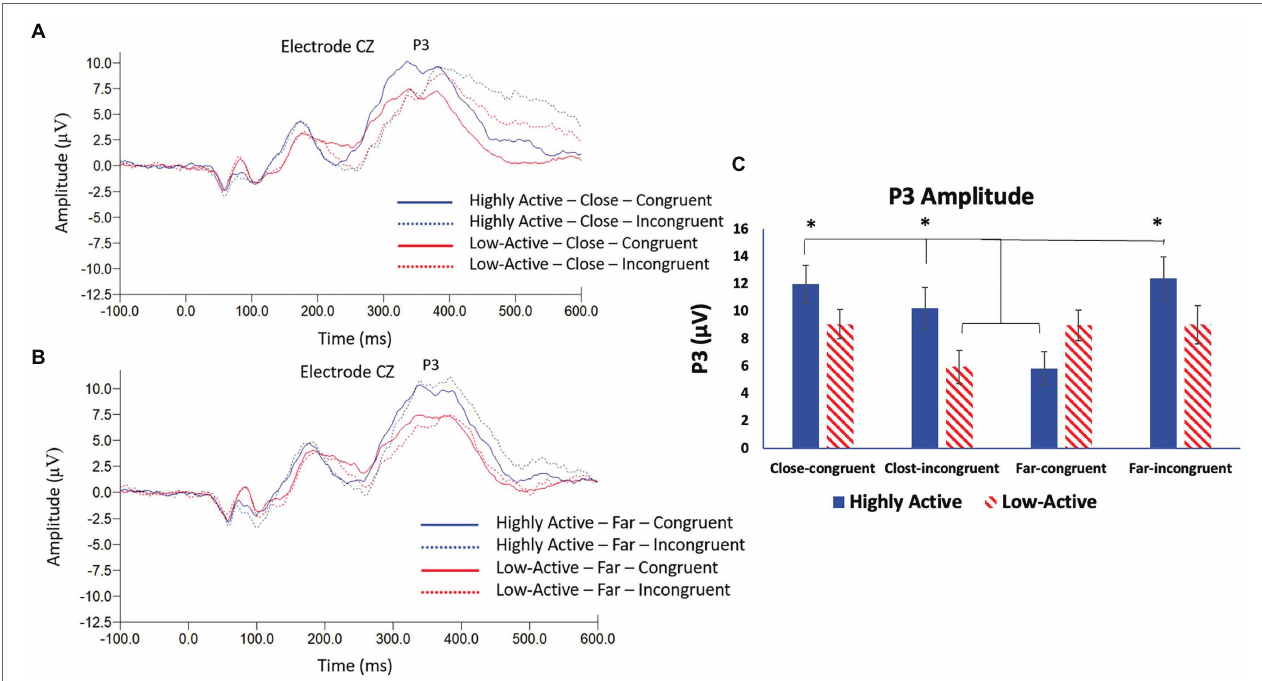
FIGURE 5 | (A) Grand average stimulus locked waveform taken from electrode CZ depicting the P3 ERP component in both groups during close, congruent, and incongruent trials. (B) Grand average stimulus locked waveform taken from electrode CZ depicting the P3 ERP component in both groups during far, congruent and incongruent trials. (C) Mean P3 amplitude—CZ. Error bars reflect SE; * denotes p <